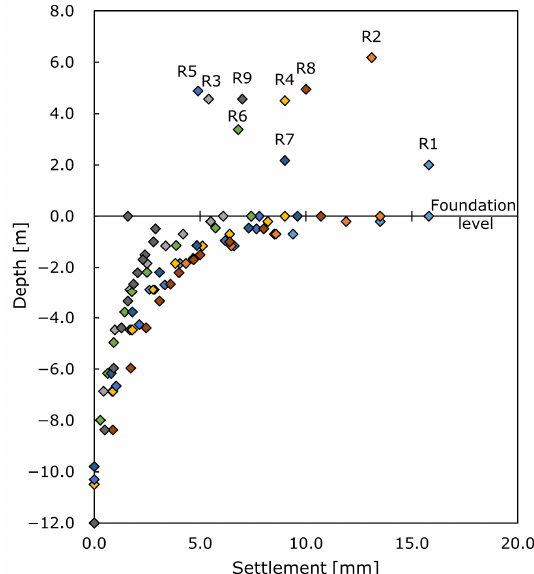
Figure 18. Settlement [mm] change with depth [m] for the benchmarks z -axis in AREA variant (total displacements).